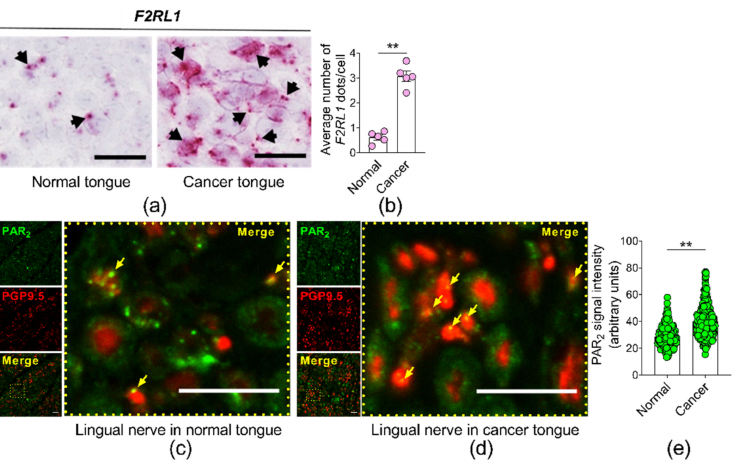
Figure 4. ( a , b ) F2RL1 mRNA expression in a human cancer tongue is elevated compared to the contralateral unaffected normal tongue in the same patient. ( a ) Microscopy shows F2RL1 expression in human cancer tongue (right panel) and contralateral unaffected normal tongue (left panel). Black arrows indicate F2RL1 chromogenic dots. ( b ) The cancer tongue expressed approximately five times the amount of F2RL1 mRNA expressed by the unaffected normal tongue. ** p < 0.01. One-way ANOVA. ( c ) PAR 2 protein in human lingual nerve innervating contralateral unaffected normal tongue compared to ( d ) cancer tongue. The lingual nerves were counterstained with PGP9.5 (a neuronal marker). ( e ) PAR 2 signal intensity in the lingual nerve innervating the cancer tongue ( n = 300 axons) was higher than PAR 2 signal intensity from lingual nerve innervating contralateral unaffected normal tongue ( n = 275 axons). Arrows indicate PAR 2 in axons. Scale bar, 10 µ m. ** p < 0.01, Student’s t -test.